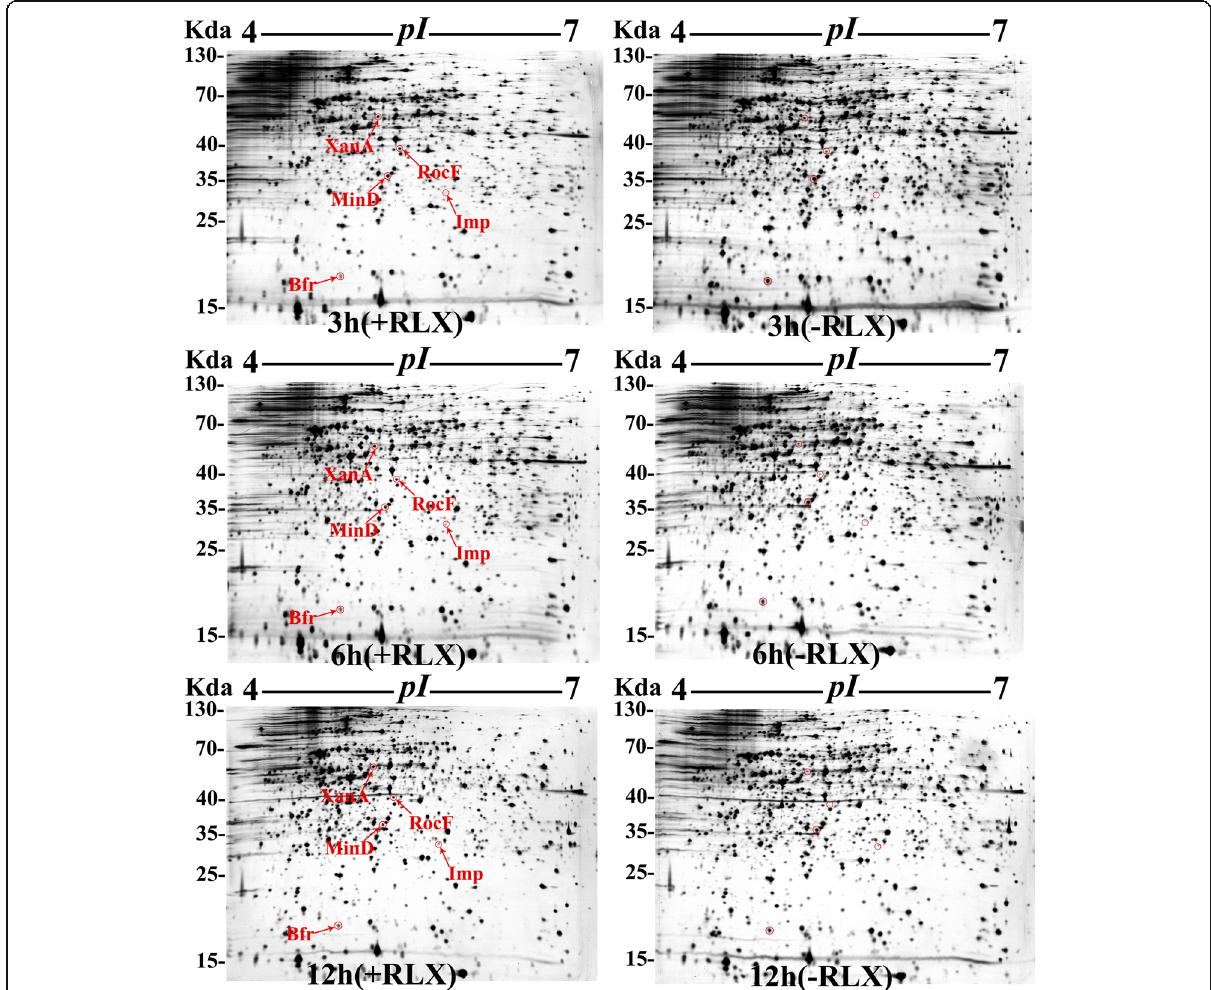
Fig. 1 Identification of host-induced proteins of X . oryzae pv. oryzae PXO99 A in the in vitro assay system using comparative proteomic analysis. Representative 2-DE profiles of the total proteins of X . oryzae pv. oryzae at 3, 6, and 12 h after treatment with NB plus rice leaf extract (+RLX; left gel) and NB ( − RLX; right gel). Protein spots that were significantly altered (|fold change| > 1.5) in +RLX groups compared to -RLX groups at all three time points are indicated by red arrows and circles. These protein spots were excised from silver-stained gels and identified via MALDI-TOF- MS. Detailed information regarding 5 successfully identified proteins was provided in Table 1. The experiments were repeated three times independently, with similar